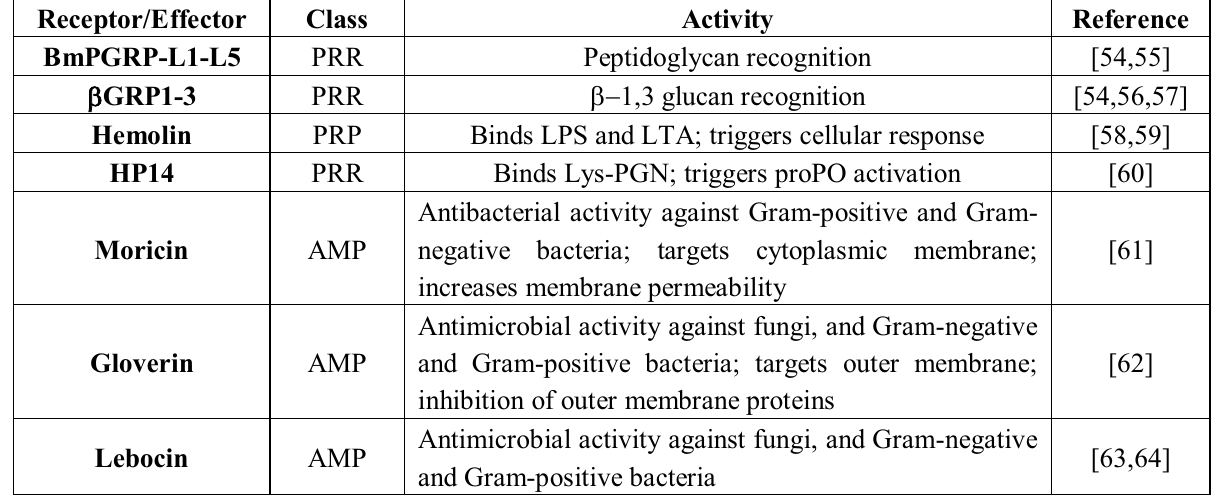
Table 1. Lepidoptera-specific immune